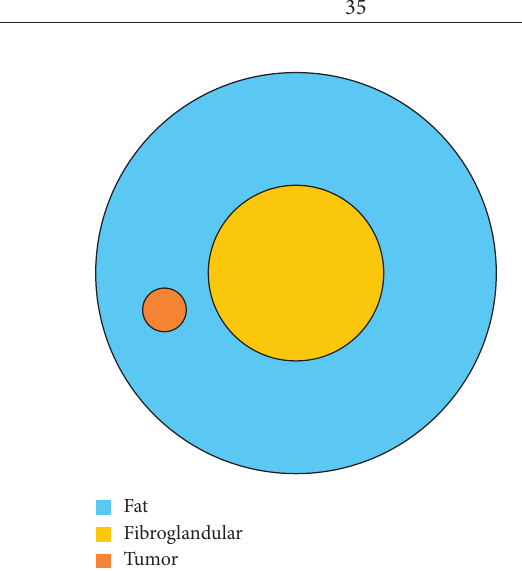
Figure 4: First scenario: tumor located inside the fat tissue.